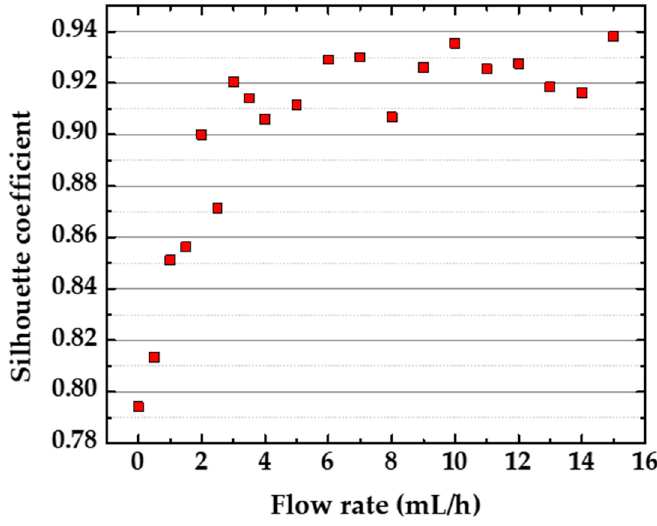
Figure 10. Silhouette coefficient (SC) for the PCA analysis of the impedance data for the sucralose-based sweeteners in aqueous solutions (10 µL/mL) obtained with a microfluidic e-tongue in distinct flow rates.